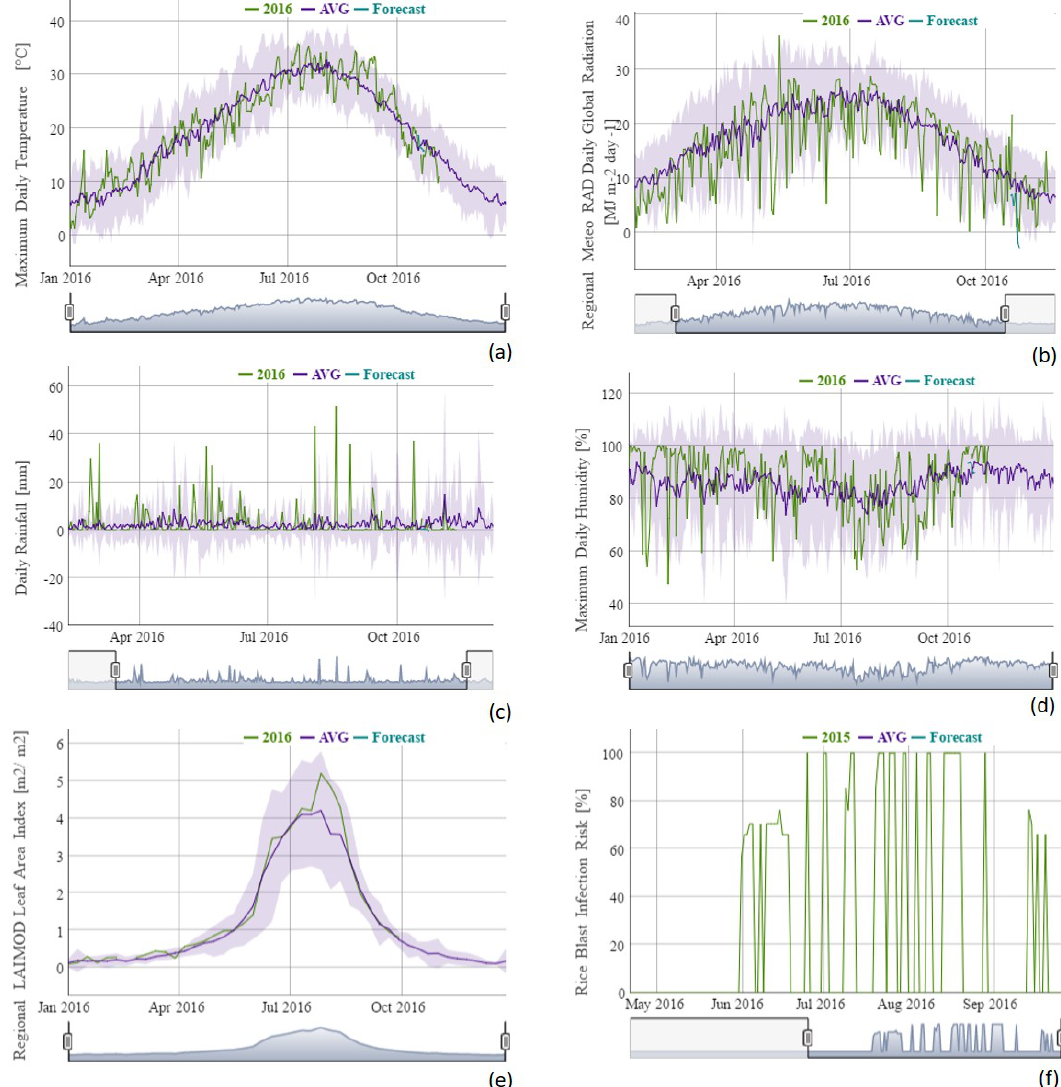
Figure 6. Examples of temporal profile charts of the Italian study area (2016): ( a ) maximum air temperature; ( b ) solar radiation; ( c ) daily rainfall; ( d ) maximum relative humidity; ( e ) leaf area index; ( f ) simulated risk of potential rice blast infection. Green line corresponds to the 2016 season, blue line is the 2003–2015 average, plus and minus one standard deviation (gray